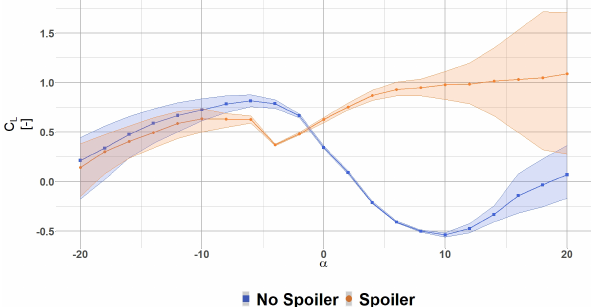
Figure 14. Mean horizontal velocity root mean square value for the radial position R6 at α = 6 ◦ ( r square (blue (cid:4) ) shows the rms for the no spoiler case, and the orange dot (orange • ) shows the rms for the spoiler case.